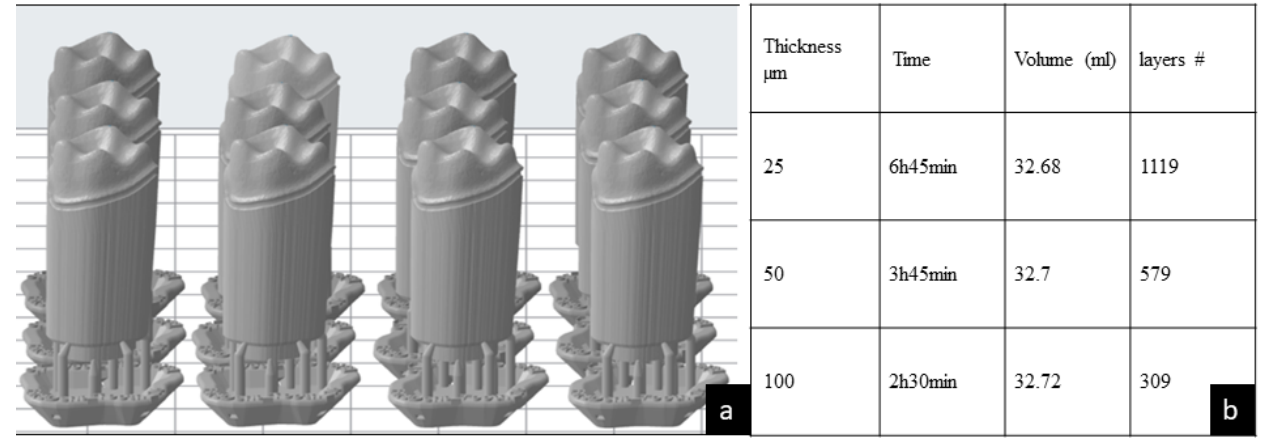
Figure 1. ( a ) Lateral view of the standard tessellation language (STL) file of 12 dental dies presented in the Preform software program. ( b ) The printing time of the 12 dental dies decreases as the printed layer thickness increases. The volume of the print remains relatively the same. The number of layers decreased gradually by increasing the thickness from group 25, to 50, to 100 µm.